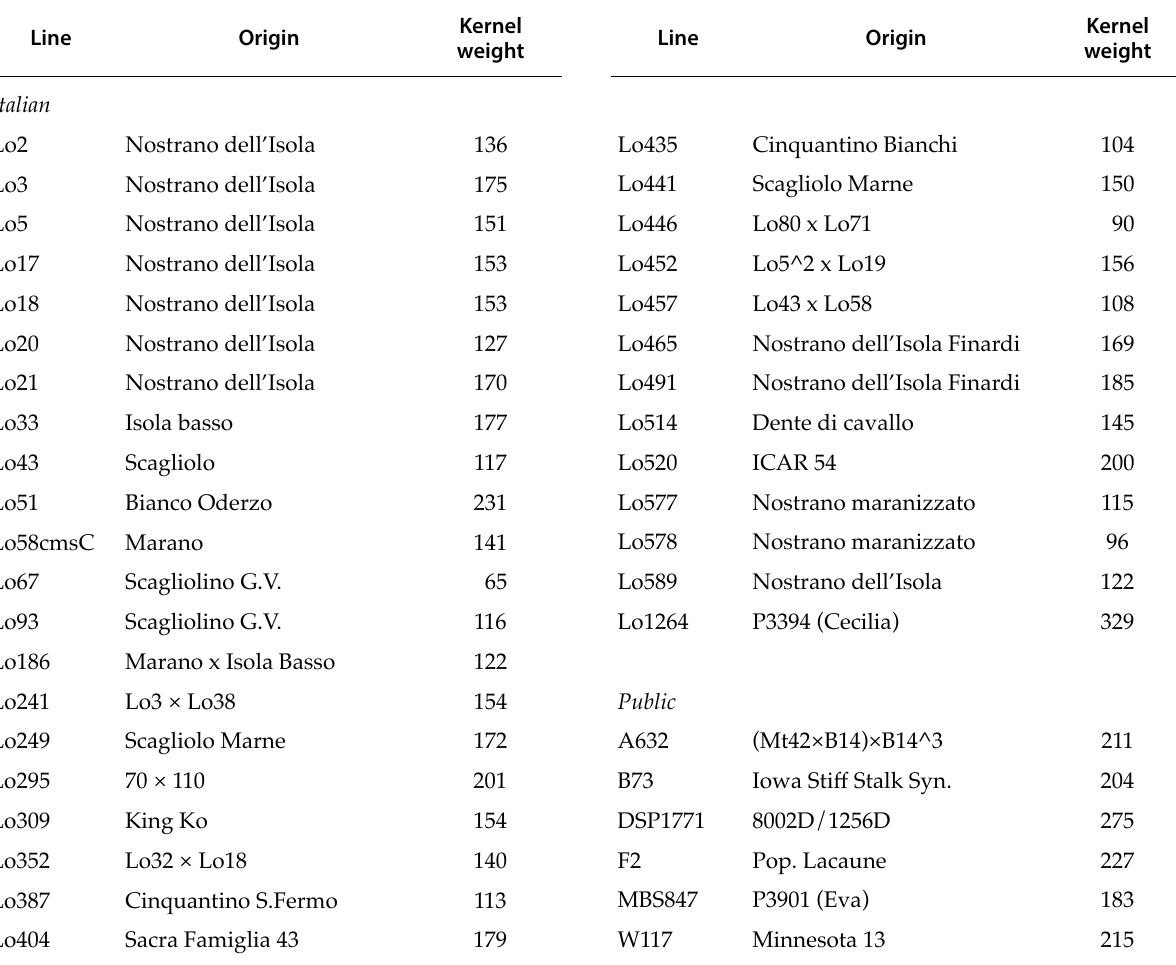
Table 1. List of the maize inbred lines investigated in this study, their origins and average kernel weights